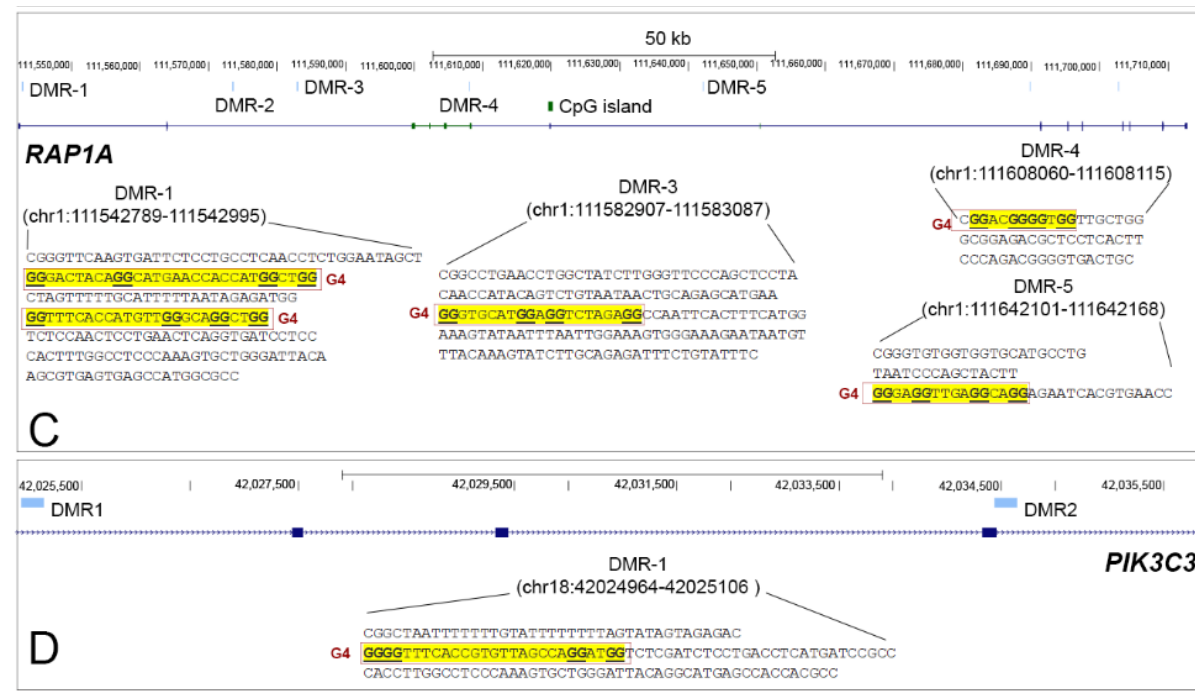
Figure 6. We observed frequent overlaps between hypomethylated DMRs and G4FS at ( A ) the promoter of DDX1 , and the body of ( B ) ZNF208 and ( C ) RAP1A . ( D ) A single G4FS was observed, overlapped to the hypermethylated DMR of PIK3C3 , while no overlap was noticed at the DMR-1 of the TERF1 promoter. Abbreviations: DMR, differentially methylated regions; G4FS, G quadruplex forming sequences.